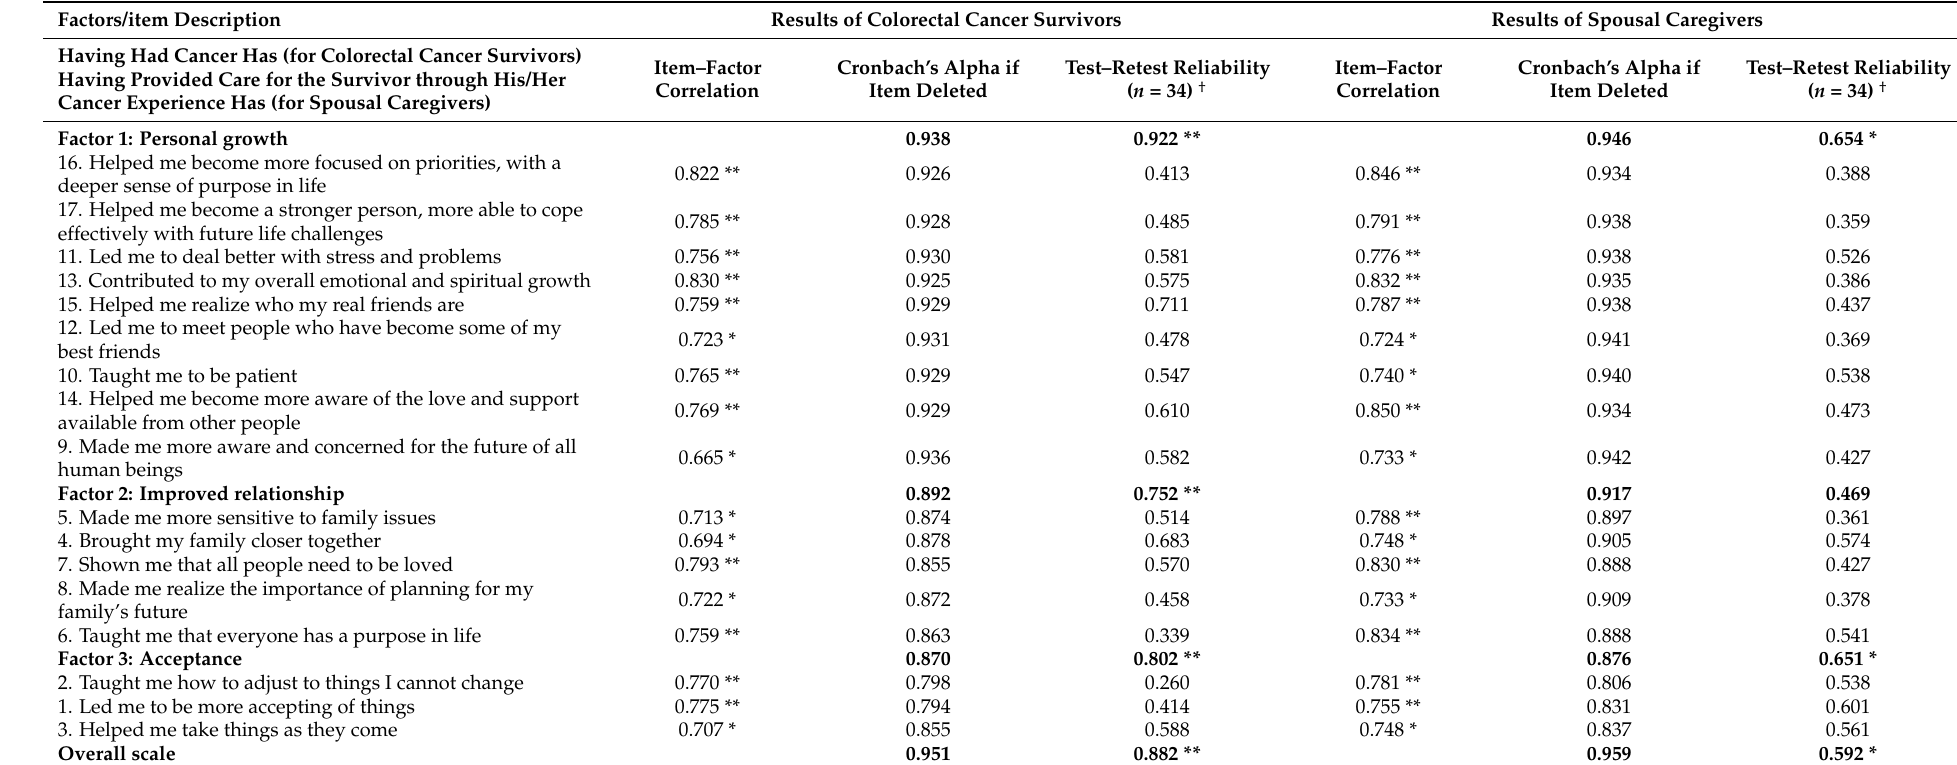
Table 3. Cronbach’s alphas for each factor and item–factor correlations, test–retest reliability ( n =